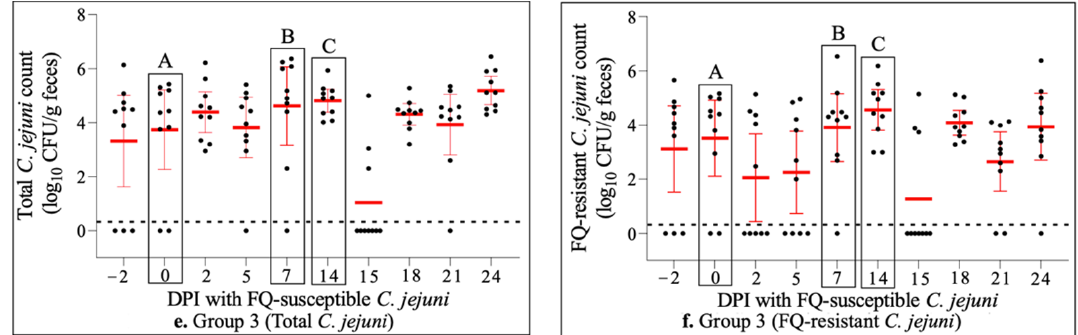
Figure 1. Dot plot graphs showing the colonization level (log 10 CFU/g feces) by total (susceptible and resistant) C. jejuni population ( a , c , e ) and FQ-resistant C. jejuni population ( b , d , f ) in three groups (Group 1, Group 2, and Group 3) of calves. The letter A denotes the time when all animals were orally inoculated (after fecal samples were collected for culture on DPI 0) with FQ-susceptible C. jejuni . The letter B indicates when the calves in Group 3 were challenged (after fecal samples were collected for culture on DPI 7) with M. haemolytica . The letter C represents subcutaneous injection (after fecal samples were collected for culture on DPI 14) with danofloxacin in Group 2 and Group 3. Each dot represents the colonization level in a single calf; the mean colonization levels are indicated by horizontal red bars, and vertical red lines represent 95% confidence intervals. The detection limit of the culture was ~100 CFU/g of feces (shown as dotted black lines over the x-axis). DPI: days post-inoculation.